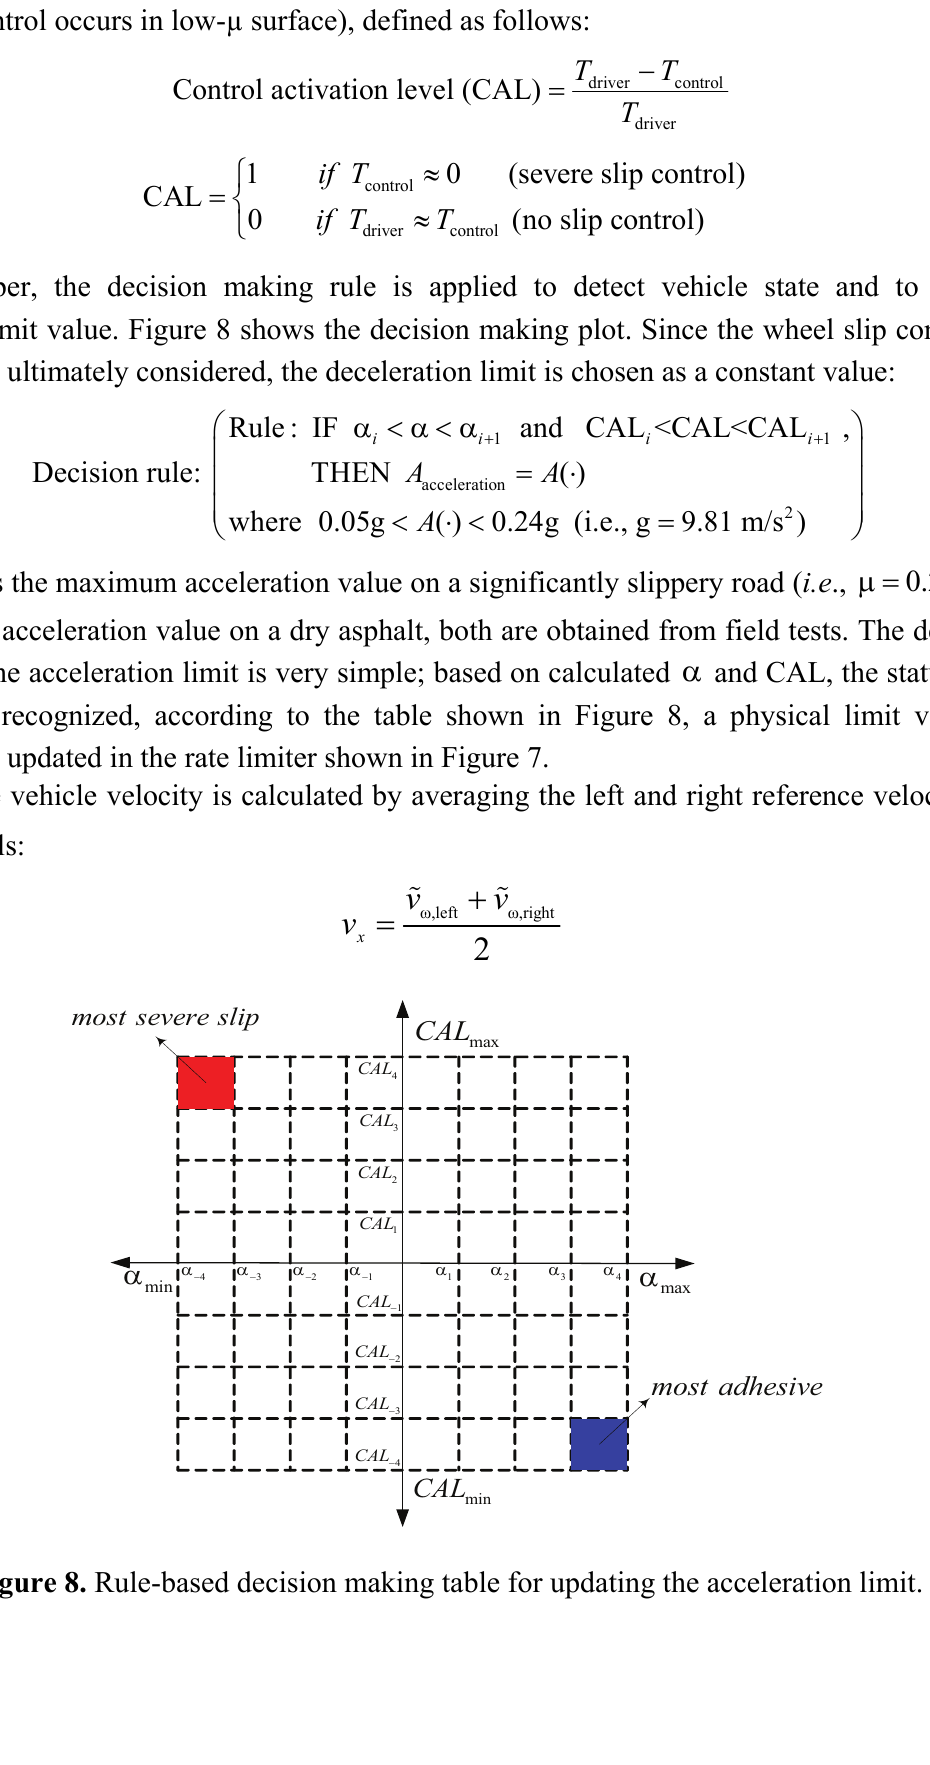
Figure 8. Rule-based decision making table for updating the acceleration limit.